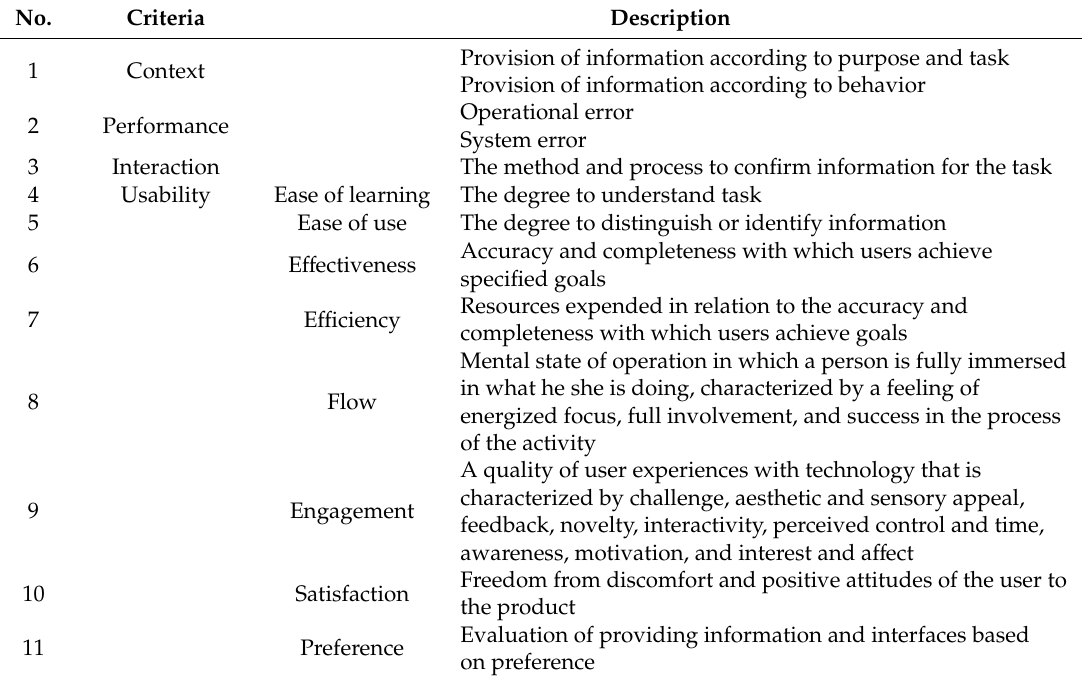
Table 2. Heuristic evaluation criteria.